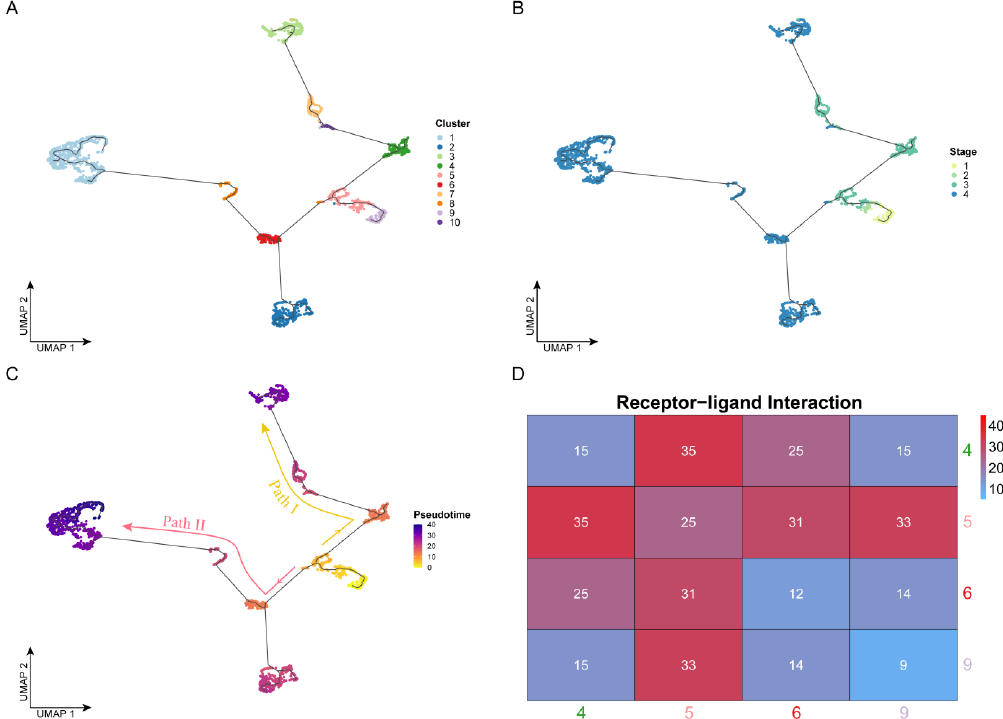
Figure 2. Cell trajectory inference: ( A – C ) Cell development trajectory. The dots represent the cells. The x - and y -axes represent the two dimensionalities of UMAP, respectively. Cells are colored by cluster label in panel A, by clinical stage in panel B, and by pseudo-time value in panel C. Based on the pseudo-time, the cell evolution direction could be determined, which was mainly divided into two paths: Path I (yellow) and Path II (red). ( D ) Results of cell communication analysis. The axis represents the four cell clusters near the branch point. The color and the number labeled by this heatmap were determined by the receptor – ligand pair number between two cell clusters.